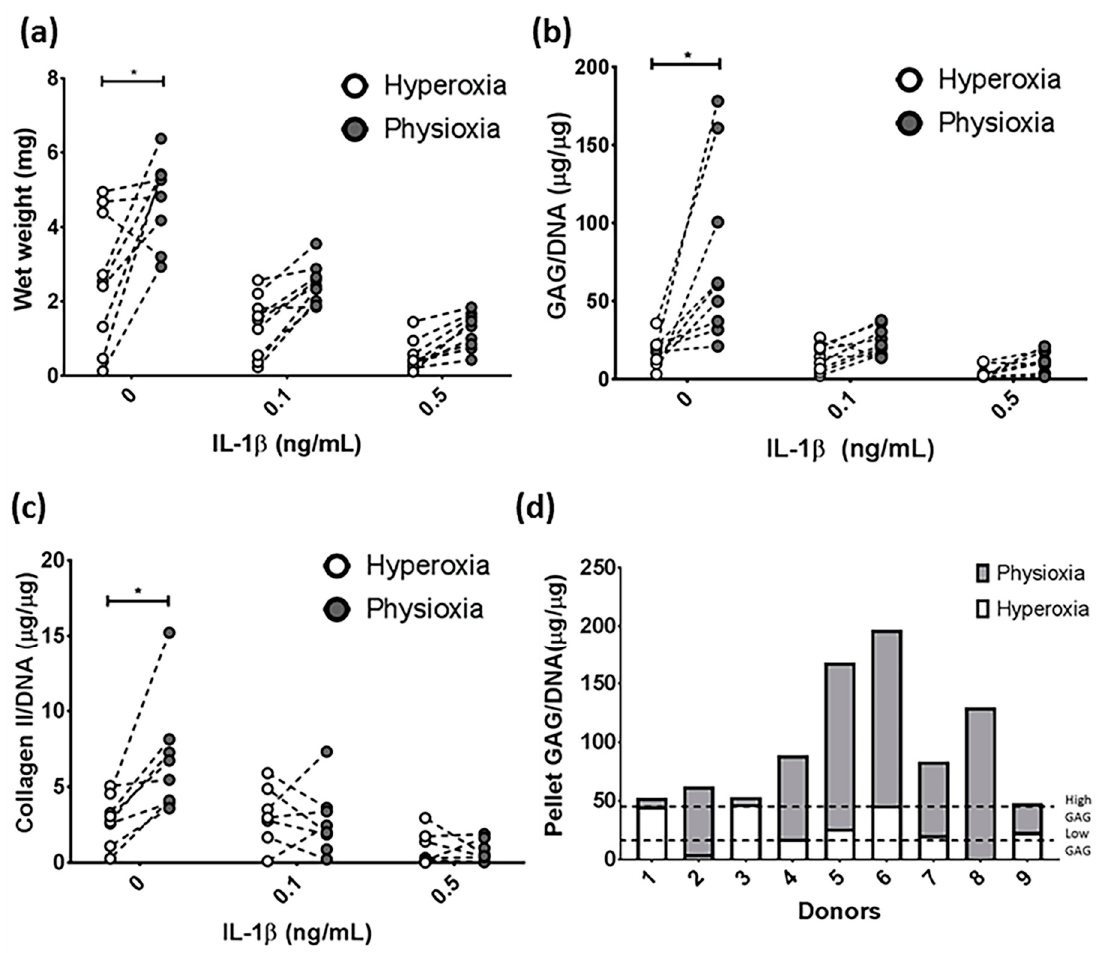
Figure 2. Donor-dependent responses in pellet ( a ) wet weight, ( b ) GAG and ( c ) collagen II content between hyperoxia and physioxia cultured chondrogenic pellets in the presence of IL-1 β . Dotted lines represent corresponding donors at hyperoxia and physioxia. Data are presented for nine independent donors (* p < 0.05). ( d ) Pellet GAG content for chondrogenic pellets under hyperoxia and physioxia. Dotted lines indicate threshold for low GAG and high GAG donors based on data from a previous publication [39].